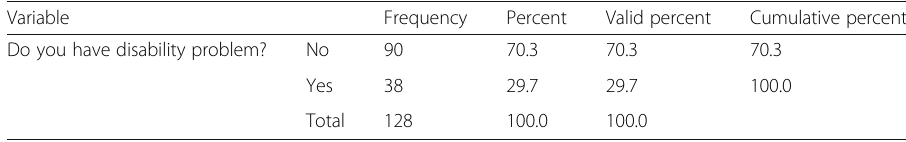
Table 5 Disability problem Variable Frequency